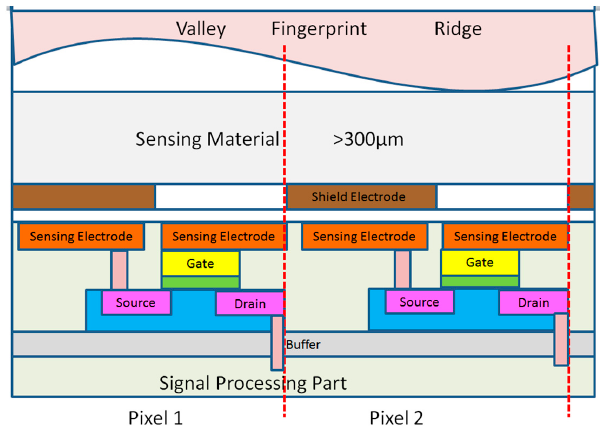
Figure 4. Electrostatic fingerprint sensor structure.